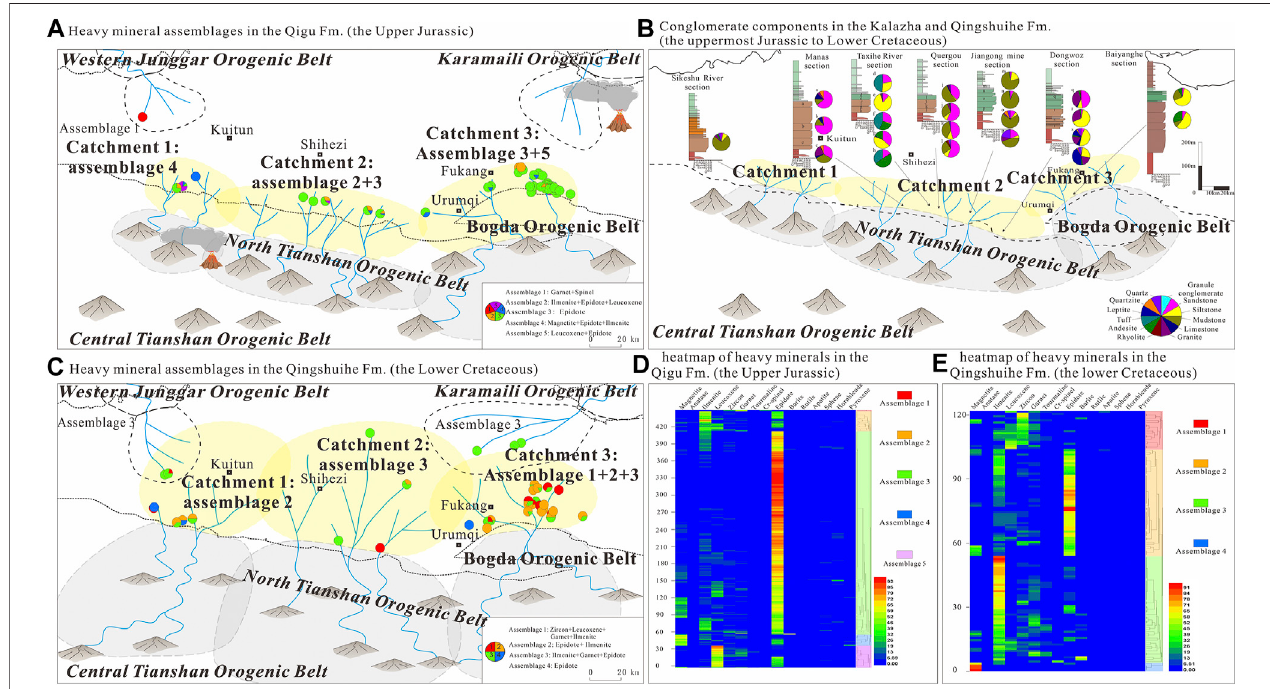
FIGURE9| DistributionofheavymineralassemblagesintheSouthernJunggarBasinduringthedepositionoftheQigu (A) andQingshuiheFormation (B) intheLate Jurassic and distribution of the conglomerate components during the deposition of the Kalazha and Qingshuihe Formation (C) . Heatmaps and clustering analysis were combined to analyze the heavy mineral assemblages in the Qigu Formation (D) and Qingshuihe Formation (E) using HemI version 1.0.3.3 software (Deng et al., 2014). The mineral percentages of each sample are shown in colors in the heatmaps (blue to red (cid:1) low-to high-percentage contents). In the distribution map, pie charts represent the proportions of heavy mineral assemblages in wells and sedimentary sections. Fm.,